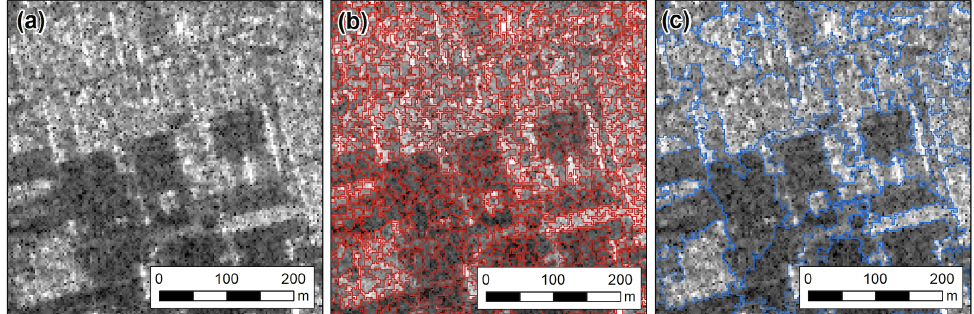
Figure 11. An example of segmentation with the smaller and larger scales: ( a ) pre-event SAR data; ( b ) small-scale segments; ( c ) large-scale segments.